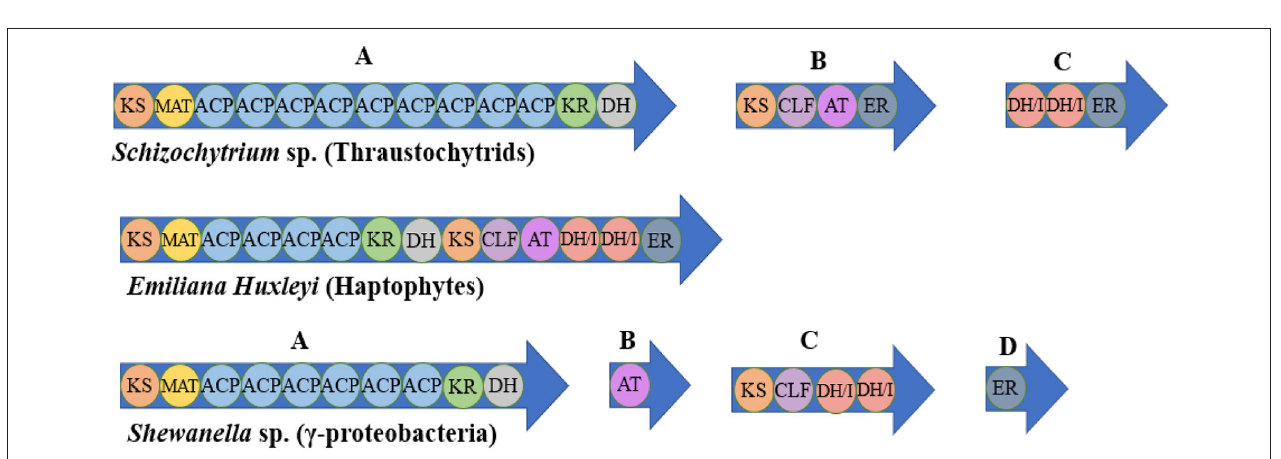
FIGURE 3 | Examples of PUFA synthase organization in various representative organisms. KS, β -ketoacyl synthase; MAT, malonyl-CoA: ACP transacylase; ACP, acyl-carrier protein; KR, β -ketoreductase; DH, dehydratase; CLF, chain length factor; AT, acyl transferase; ER, enoyl-reductase; DH/I, dehydratase/isomerase.